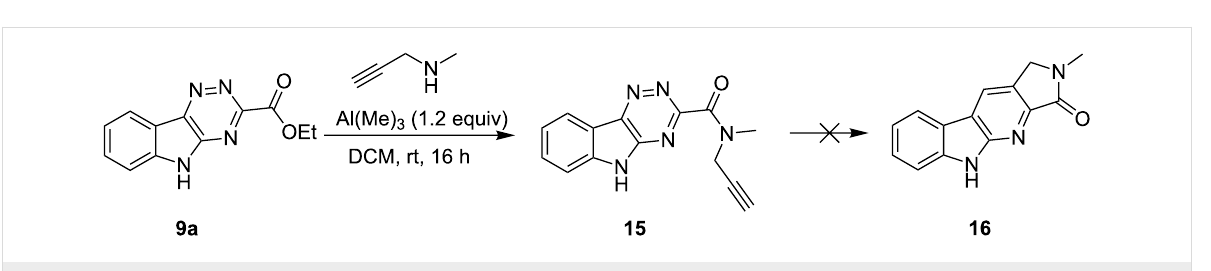
Scheme 8: Preparation of unprotected triazine 15 , and its lack of reactivity in